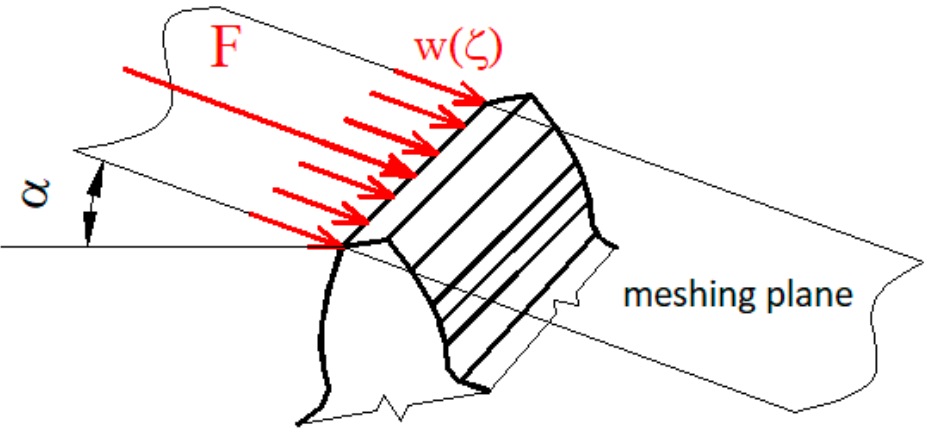
Figure 4. Expression of continuous load by single force.